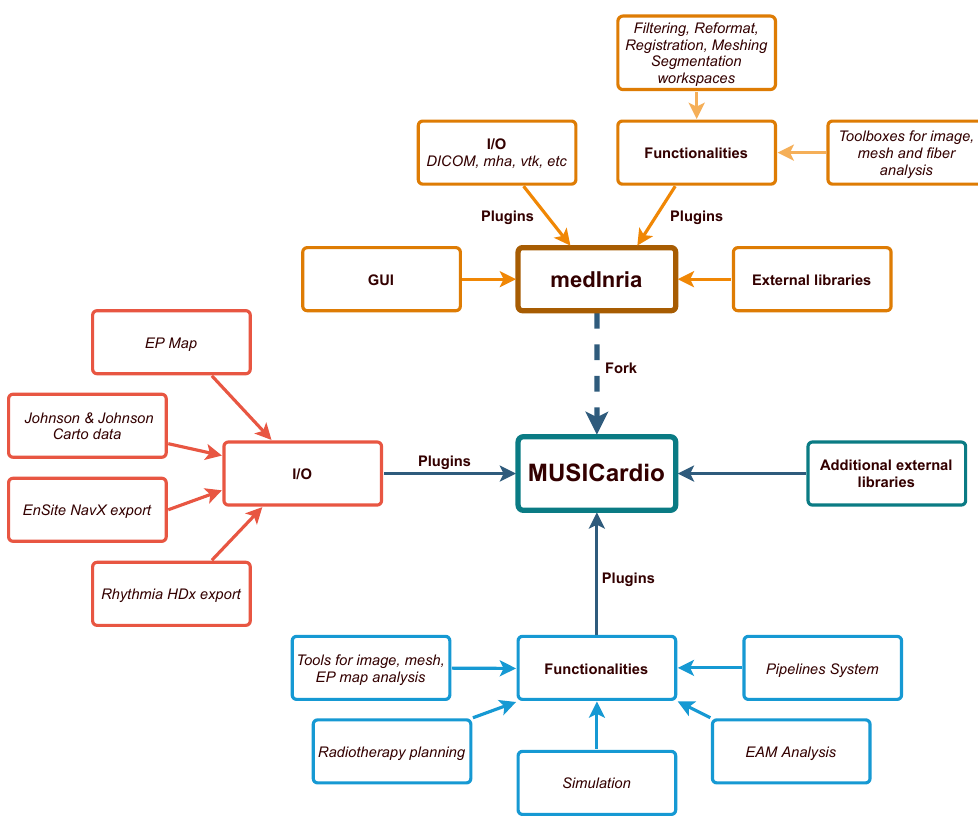
Figure 2. MUSICardio